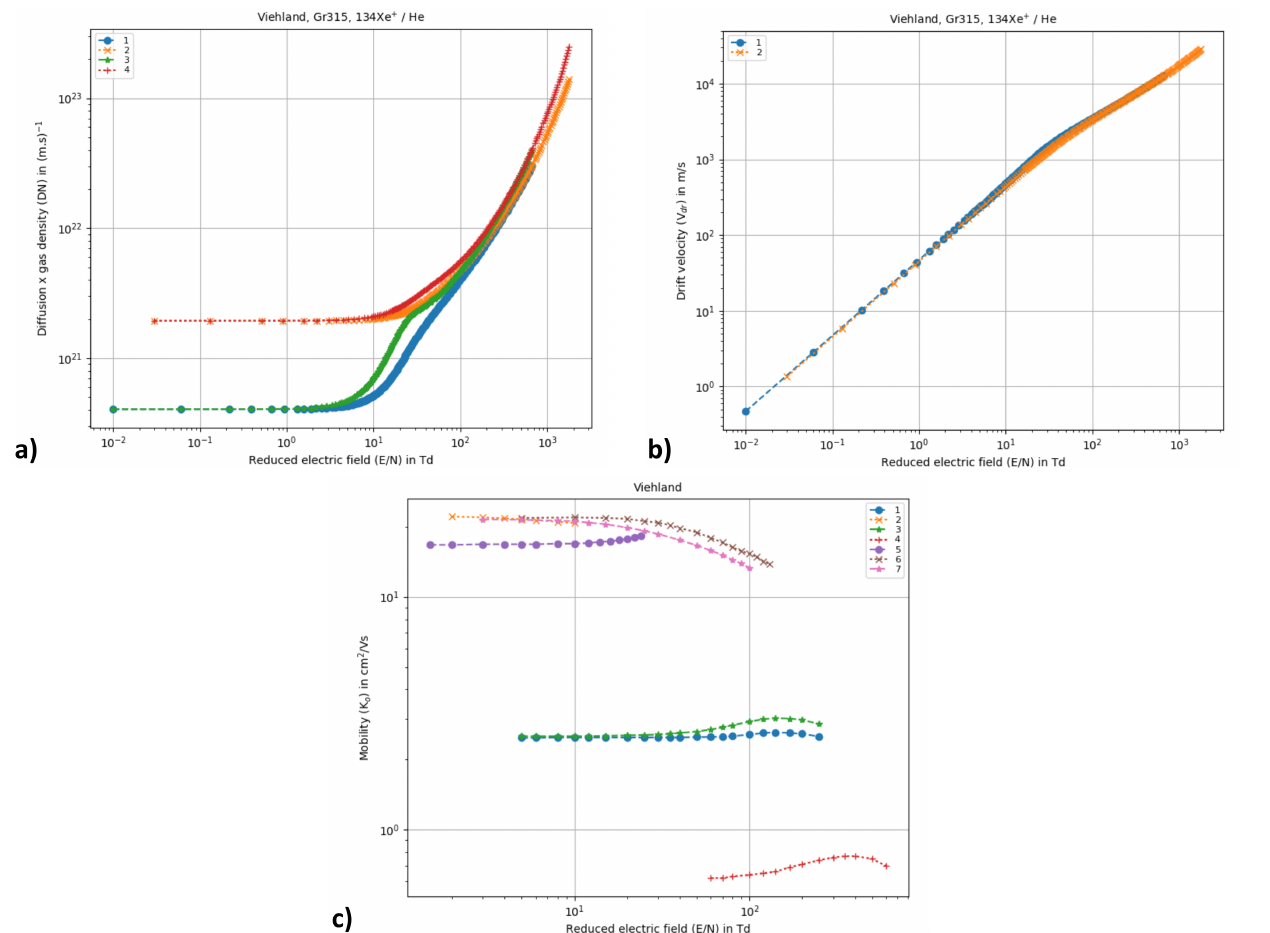
Figure 8. Sample of different types of swarm parameters taken from Viehland’s database plotted for some different ions in different background gases as a function of the reduced electric field E/N in Td [158]. ( a ) Product of gas number density and ion diffusion coefficient in the perpendicular ( ND x ) (curves 1–2) and parallel ( ND z ) directions to the electric field (curves 3–5) for 2 different temperatures of 100 and 500 K (curves 2 and 4 for the latter) [176]. ( b ) Ion drift velocity of Xe + ions in He at 100 K (curve 1) and 500 K (curve 2) [176]. ( c ) Ion mobility in different background gases at 300 K [177,178]: